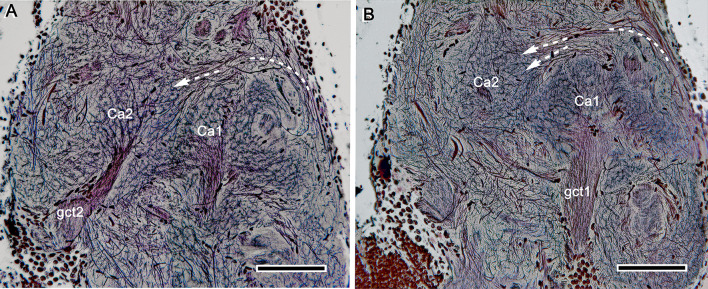
Calyx distinctions.(A, B) Two serial silver-stained sections showing the side-by-side disposition of calyces 1, 2 (Ca1, Ca2) each supplied by its own globuli cell tract (gct1, 2). Arrowed paths indicate passage of axons extending to Ca2 from pathways (far right in both panels) from the optic lobe medulla and reniform body. Scale bars, 100 μm.